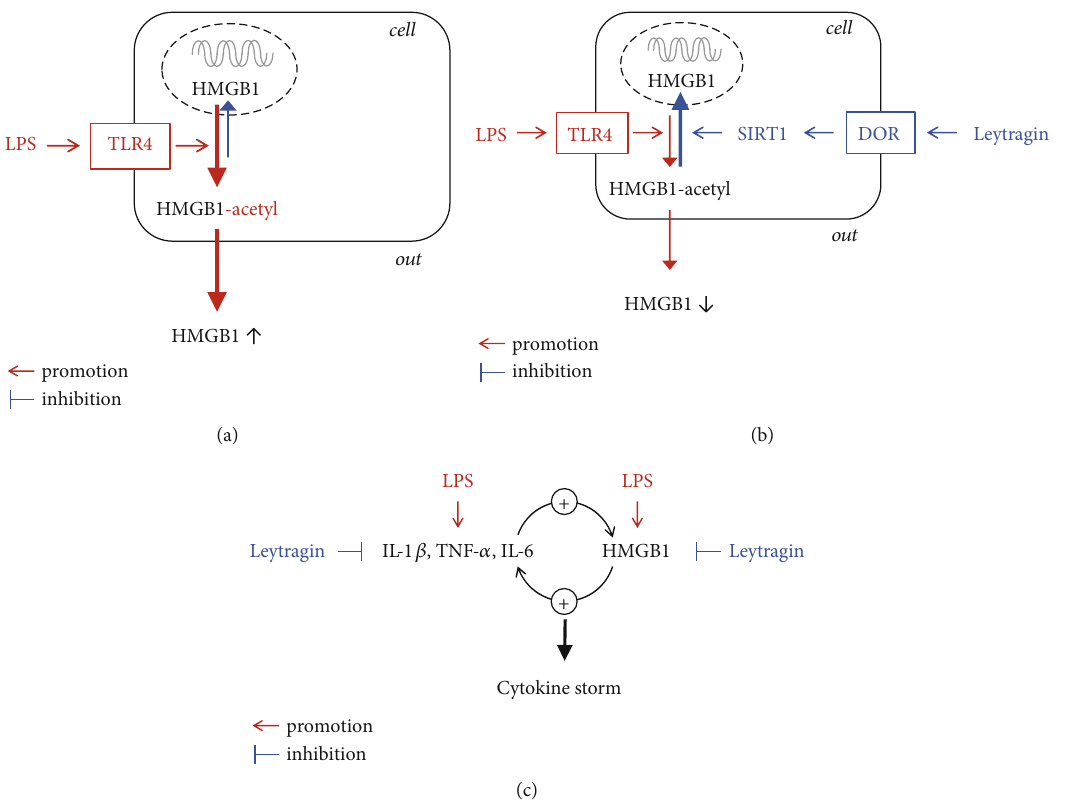
Figure 6: Schematic diagram illustrating the modes of leytragin action in a mouse model of LPS-induced pulmonary in fl ammation. (a) LPS via TLR4 triggers HMGB1 hyperacetylation, followed by HMGB1 ’ s translocation from the nucleus to the cytoplasm and then to the extracellular milieu [13, 24]. (b) Leytragin via DOR upregulates SIRT1 expression, causing deacetylation of HMGB1 [16 – 18], thereby redirecting HMGB1 to the nucleus and preventing its release into the extracellular milieu. (c) Leytragin inhibits the LPS-induced production of proin fl ammatory cytokines, as well as HMGB1 release, thereby inhibiting the progression to cytokine storms and lethal